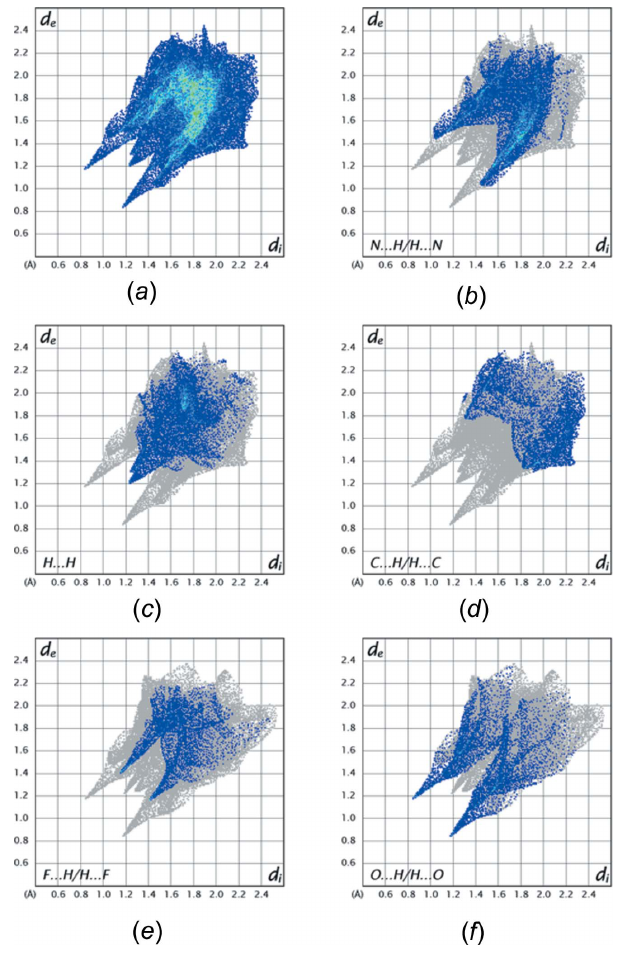
Figure 7 Fingerprint plots for the molecule containing O2 showing intermolecular interactions. ( a ) all; ( b ) N (cid:2)(cid:2)(cid:2) H/H (cid:2)(cid:2)(cid:2) N; ( c ) H (cid:2)(cid:2)(cid:2) H; ( d ) C (cid:2)(cid:2)(cid:2) H/H (cid:2)(cid:2)(cid:2) C; ( e ) F (cid:2)(cid:2)(cid:2) H/H (cid:2)(cid:2)(cid:2) F; ( f ) O (cid:2)(cid:2)(cid:2) H/H (cid:2)(cid:2)(cid:2) O.